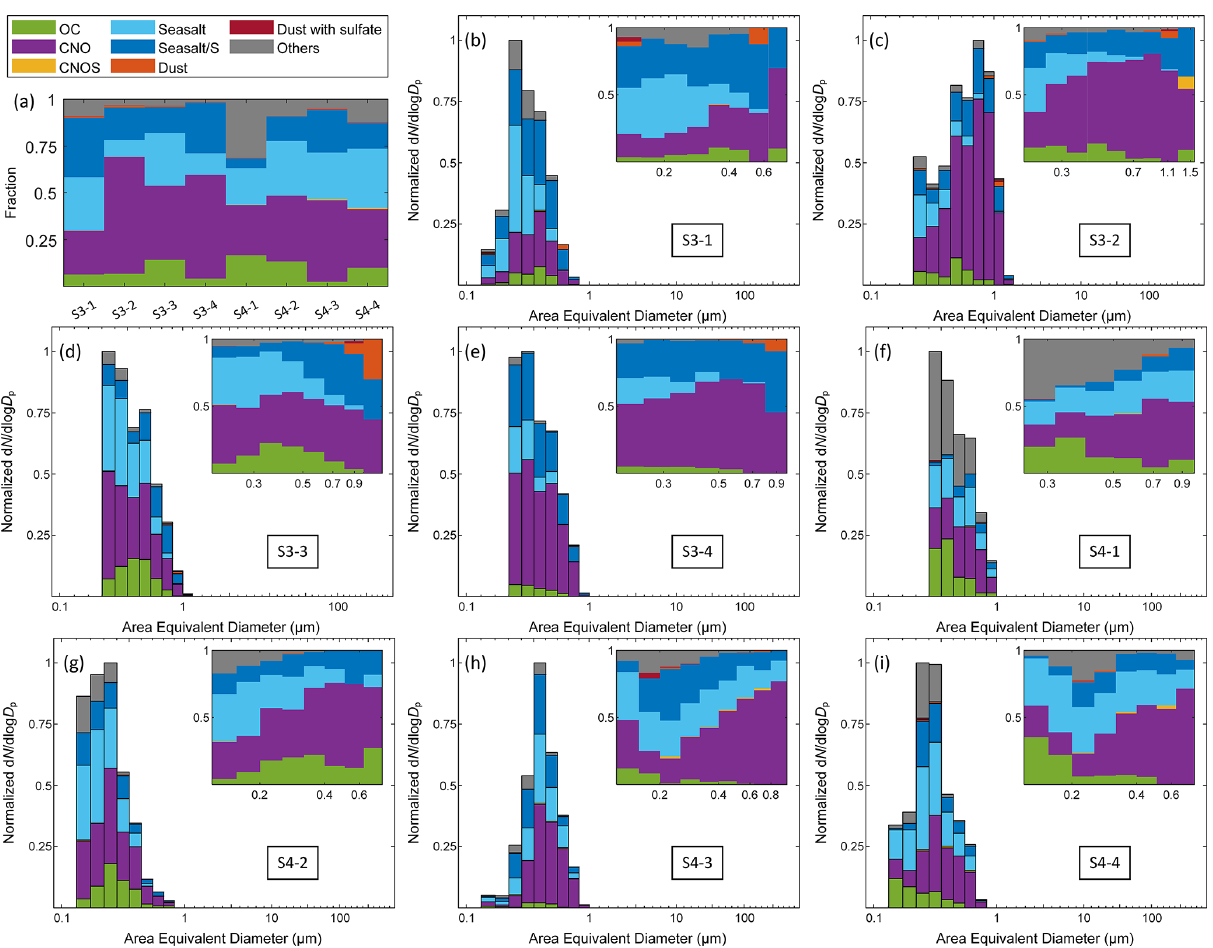
Figure 3. Chemically resolved size distributions were inferred from the CCSEM-EDX data for 2017. (a) Fractions of different particle types for all samples. Normalized chemically resolved size distributions of (b) S3-1, (c) S3-2, (d) S3-3, (e) S3-4, (f) S4-1, (g) S4-2, (h) S4-3, and (i) S4-4. Insets represent the normalized number fractions of different particle types as a function of particle